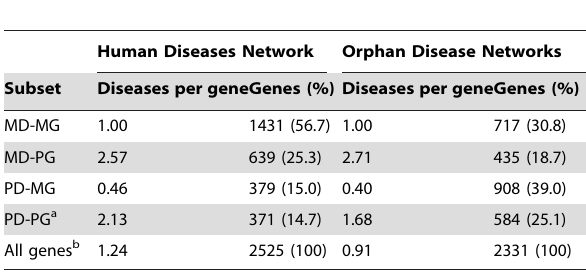
Table 2. Distribution of disease-to-gene associations on proposed classification.